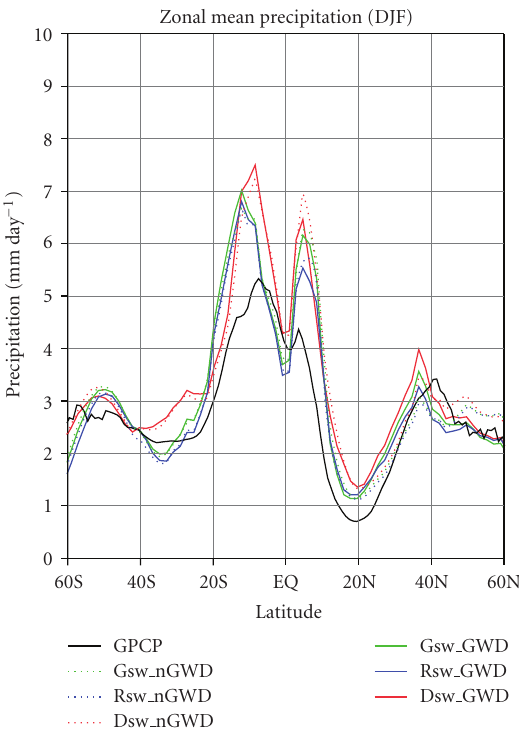
Figure 4: The zonal-mean of the 3-year mean daily precipitation (mm day − 1 ) obtained from the three nGWD (dotted lines) and three GWD (solid lines) experiments with the Goddard (green lines), RRTMG (blue lines), and Dudhia (red lines) shortwave radiation schemes,